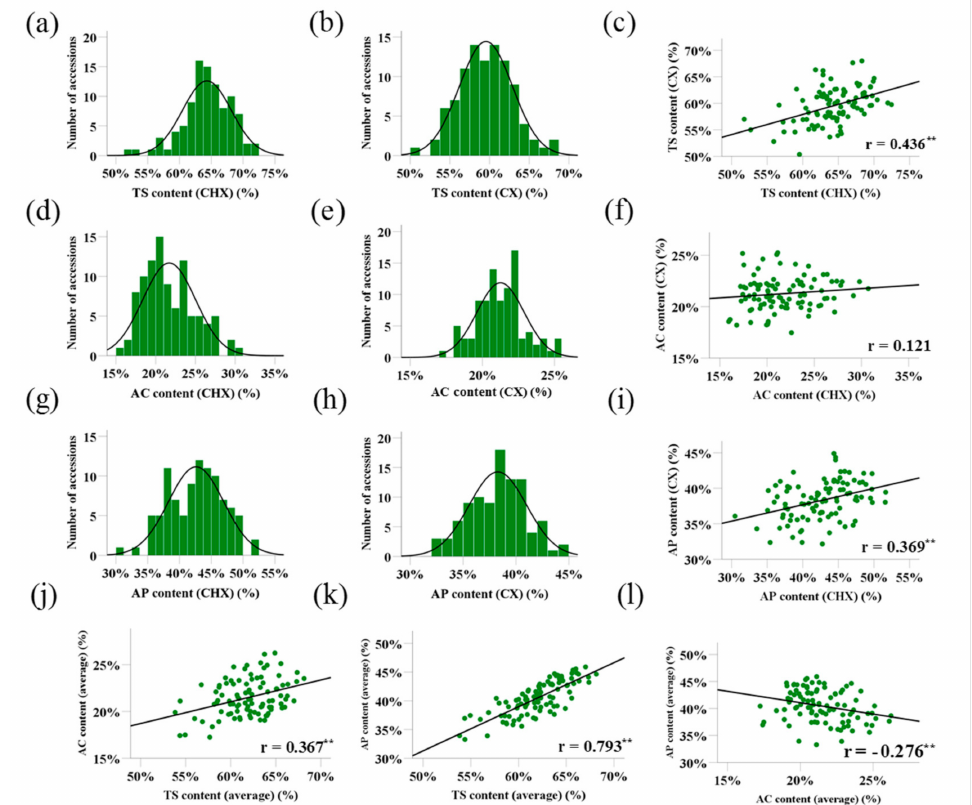
Figure 1. Frequency distribution and correlation analysis of TS, AC and AP content. ( a , b ) the frequency distribution of TS in Changxing and Cixi; ( c ) the correlation of TS between Changxing and Cixi; ( d , e ) the frequency distribution of AC in Changxing and Cixi; ( f ) the correlation of AC between Changxing and Cixi; ( g , h ) the frequency distribution of AP in Changxing and Cixi; ( i ) the correlation of AP between Changxing and Cixi; ( j ) the correlation of TS and AC; ( k ) the correlation of TS and AC; ( l ) the correlation of AC and AP. TS, Total starch content; AC, Amylose content; AP, Amylopectin content. ** representing significance at p < 0.01 level, respectively